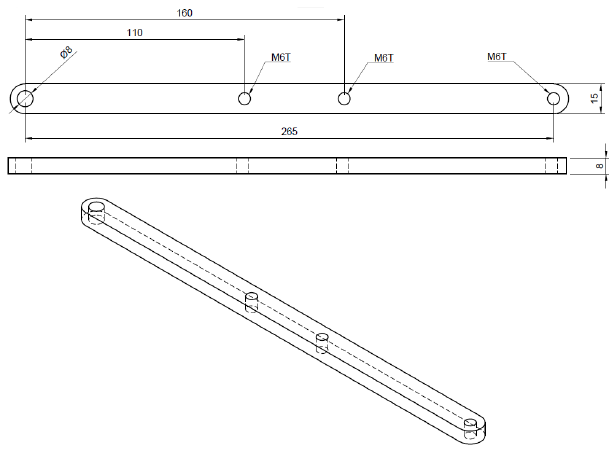
Figure 9. Schematic representation of the arm rod. Sizes shown are just for reference and have not been optimized. The design will require adjustments.